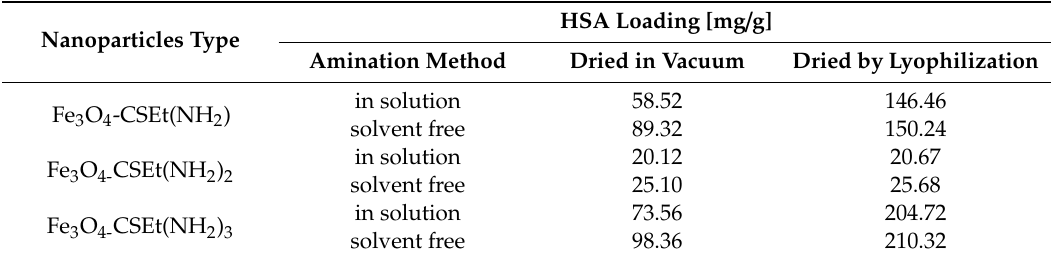
Table 3. Results of HSA immobilization on magnetic nanoparticles Fe 3 O 4- CSEt(NH 2 )